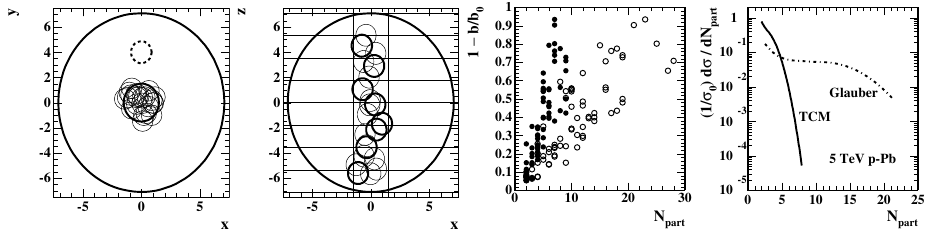
Figure 5. First: Nucleons within eikonal corridor for b = 0 projectile. Second: p - N encounters (22 total circles) and actual collisions with exclusion-time constraint (8 dark circles). Third: Glauber-model relation of relative impact parameter b / b 0 to participant number N part with (solid) and without (open) an exclusion-time constraint. Fourth: Di ff erential cross section on N part with (solid) and without (dash- dotted) an exclusion-time